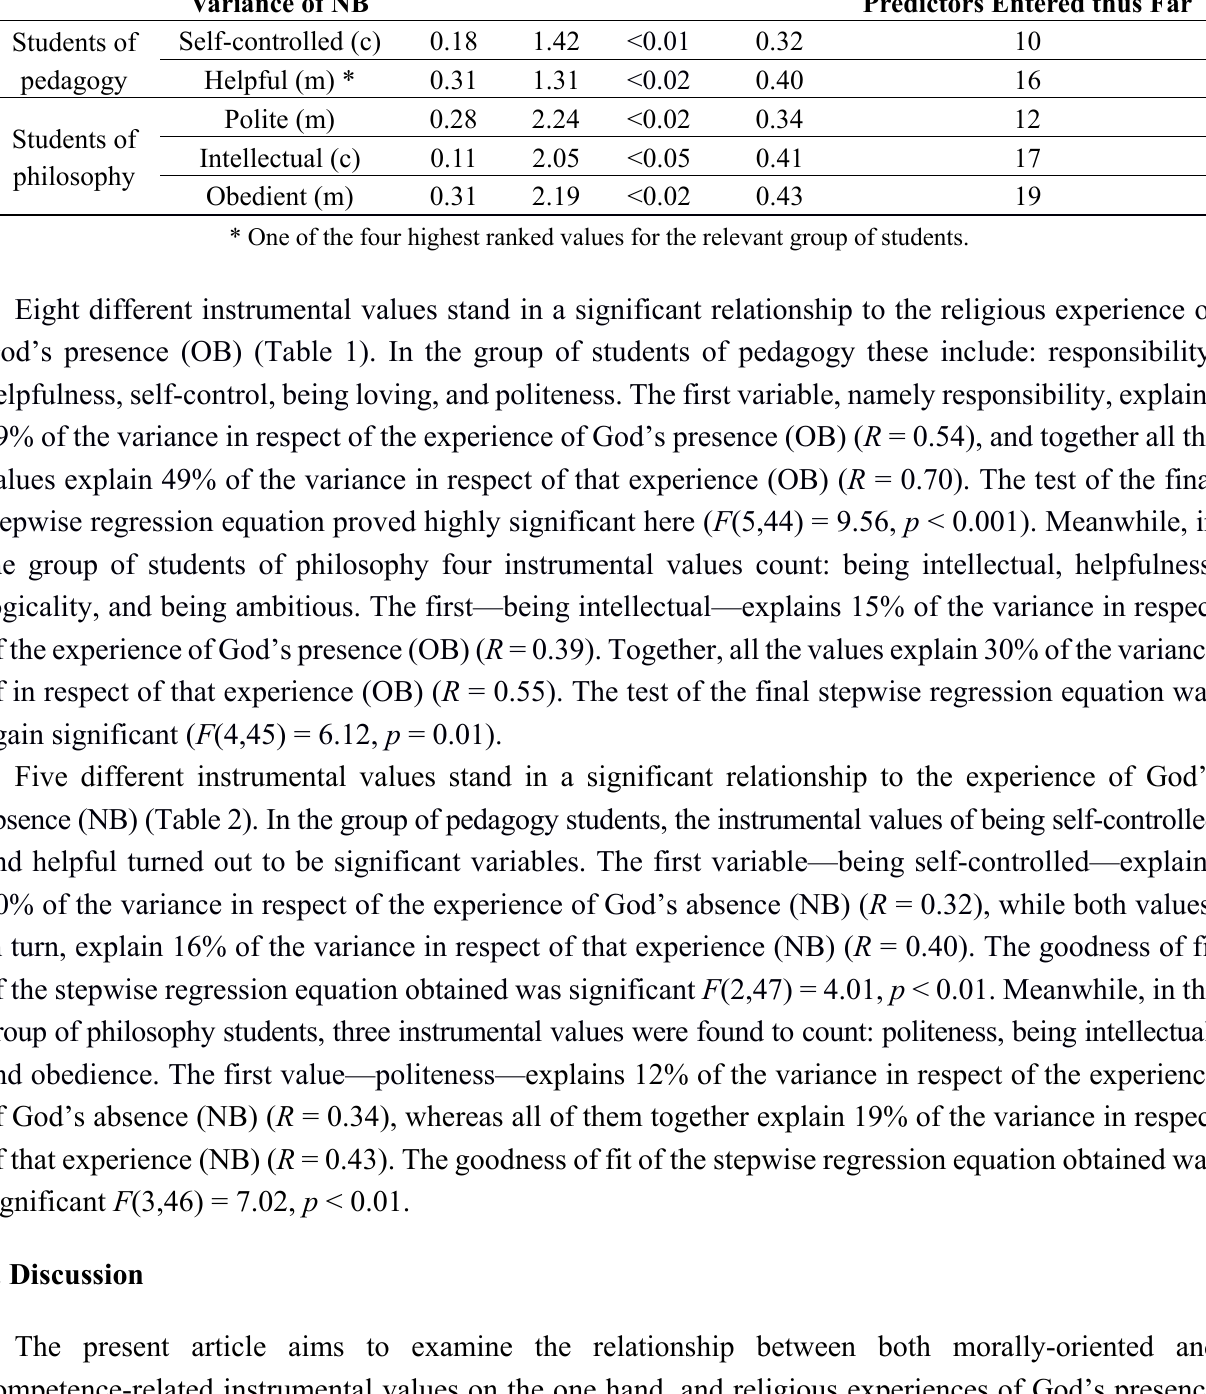
Table 2. Independent variables relating to instrumental values with a moral (m) and a competence (c) character explaining variance, in respect of experiences of God’s absence (NB), in groups of students of pedagogy and students of philosophy. Cumulative Percentage of Variables Multiple Variance Explained by the Groups Explaining the B t p R Predictors Entered thus Far Variance of NB Self-controlled (c) 0.18 1.42 <0.01 0.32 10 Students of pedagogy Helpful (m) * 0.31 1.31 <0.02 0.40 16 Polite (m) 0.28 2.24 <0.02 0.34 12 Students of Intellectual (c) 0.11 2.05 <0.05 0.41 17 philosophy Obedient (m) 0.31 2.19 <0.02 0.43